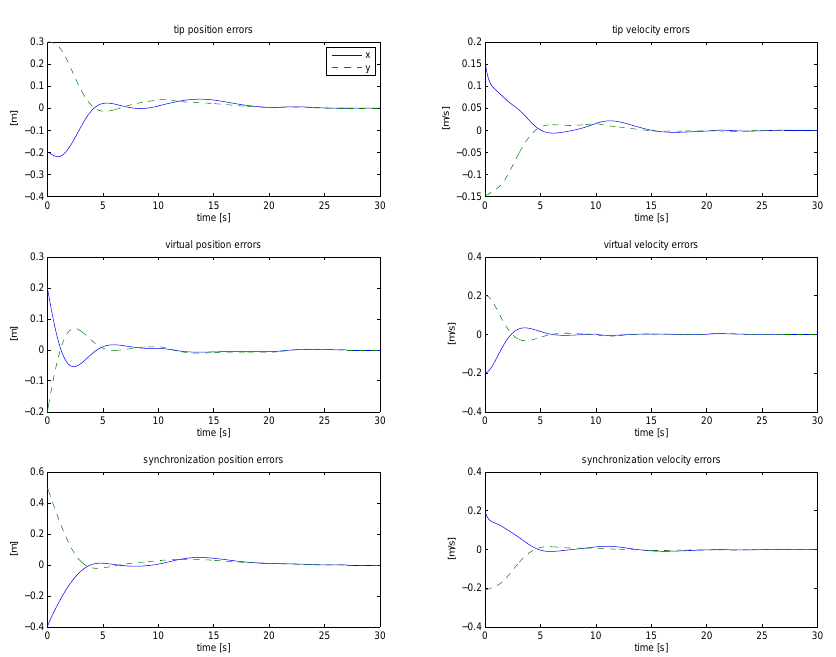
x m in the upper row, the virtual manipulator control errors x v Figure 2: The total errors x − x v in the lower row, with positions [m] on the left and velocities row, and the coordination errors x − [m/s] on the